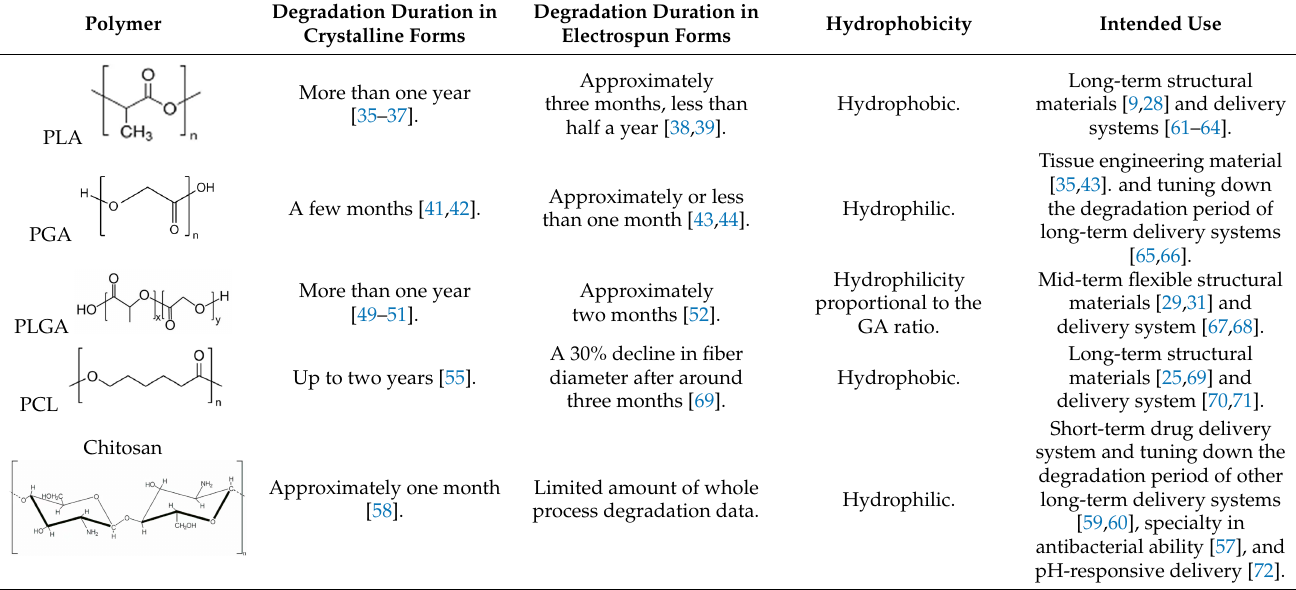
Table 1. Summary of typical implantable polymers for electrospinning.